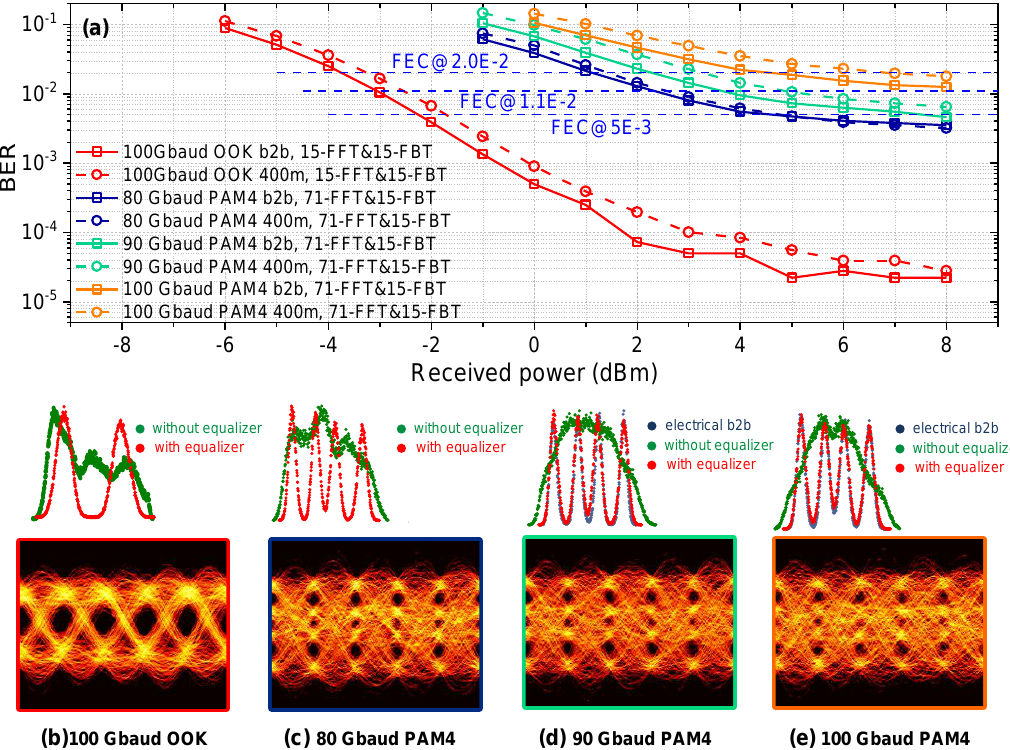
Figure 4. ( a ) BER curves for OOK and PAM4 signal for b2b and 400 m, ( b – e ) eye diagram and histograms for optical b2b at ROP of 8 dBm .